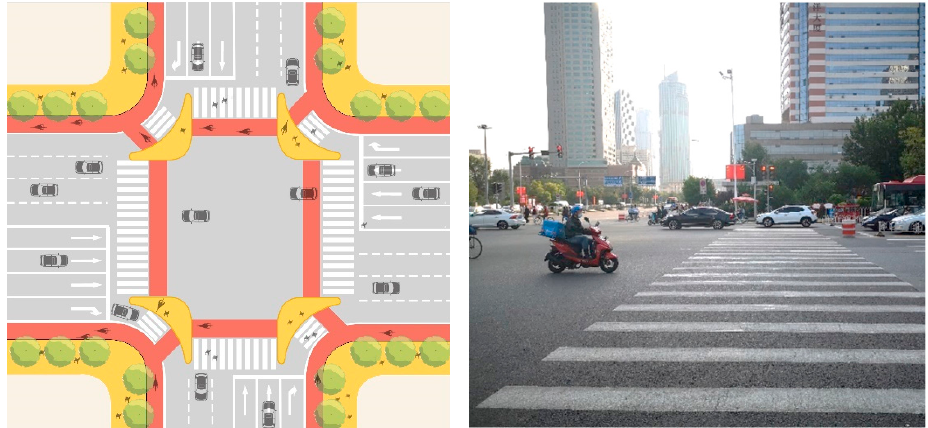
Achieve Traffic Calm and Stability